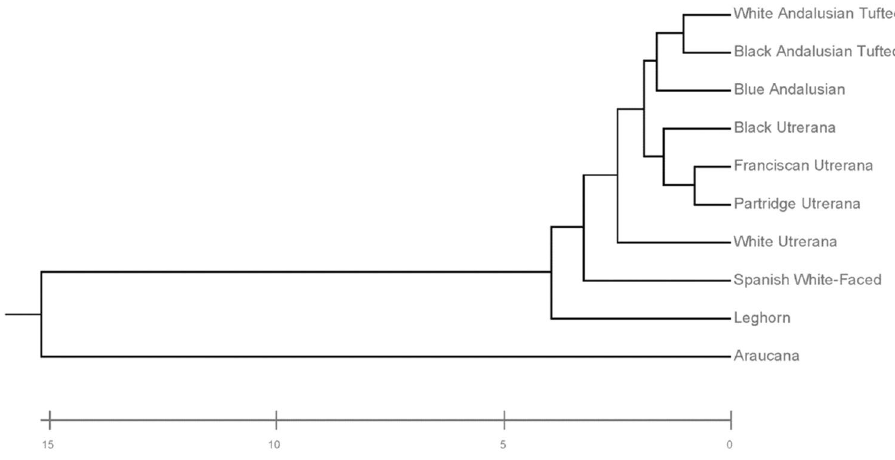
Figure 5. Cladogram constructed from Mahalanobis’s distances between laying hen